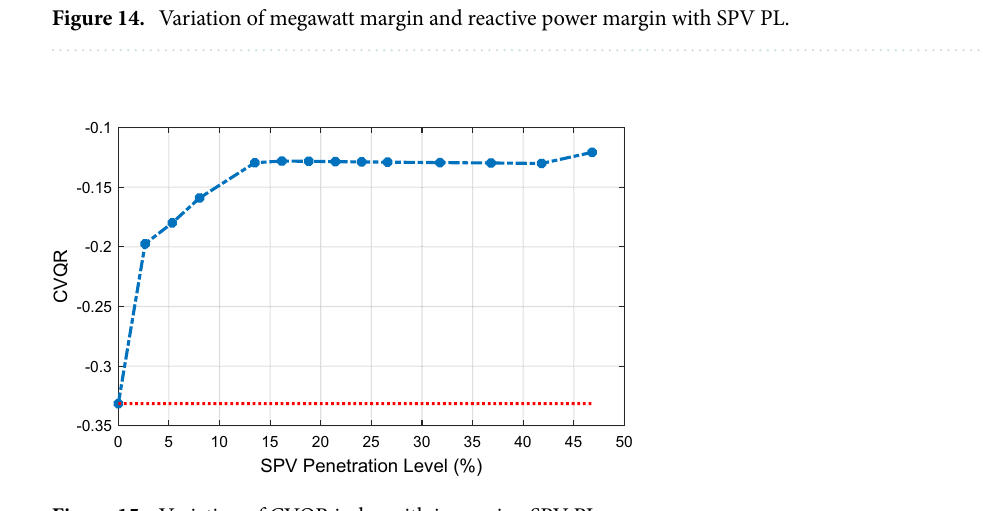
Figure 15. Variation of CVQR index with increasing SPV